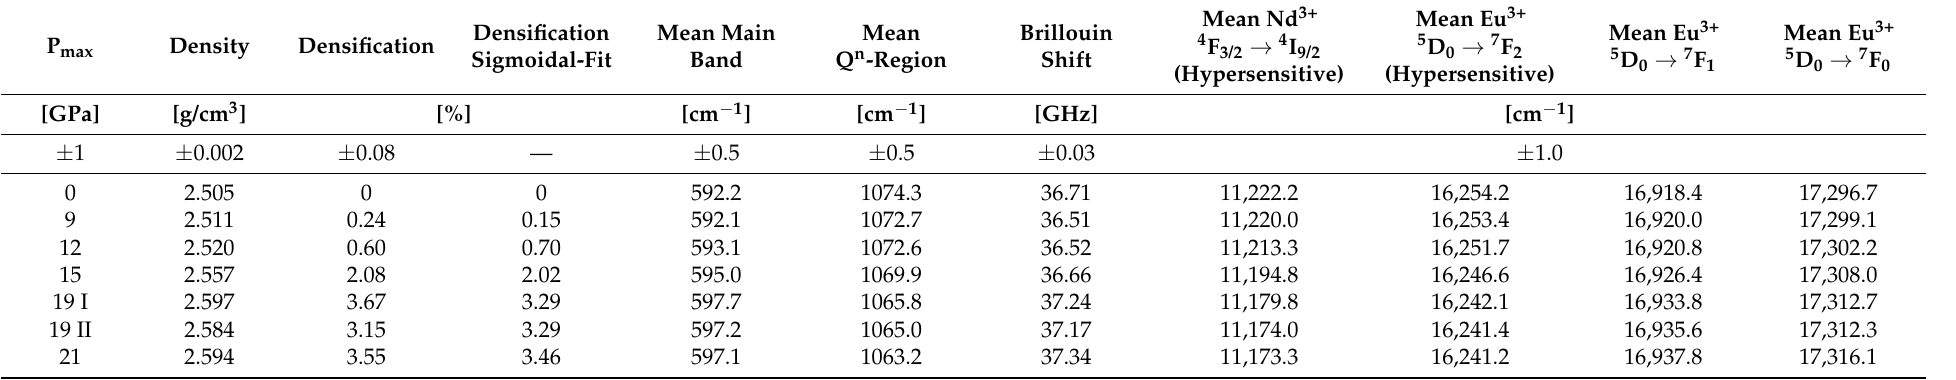
Table A4. Experimental and spectroscopic data (mean · I ) of the permanently densified glass